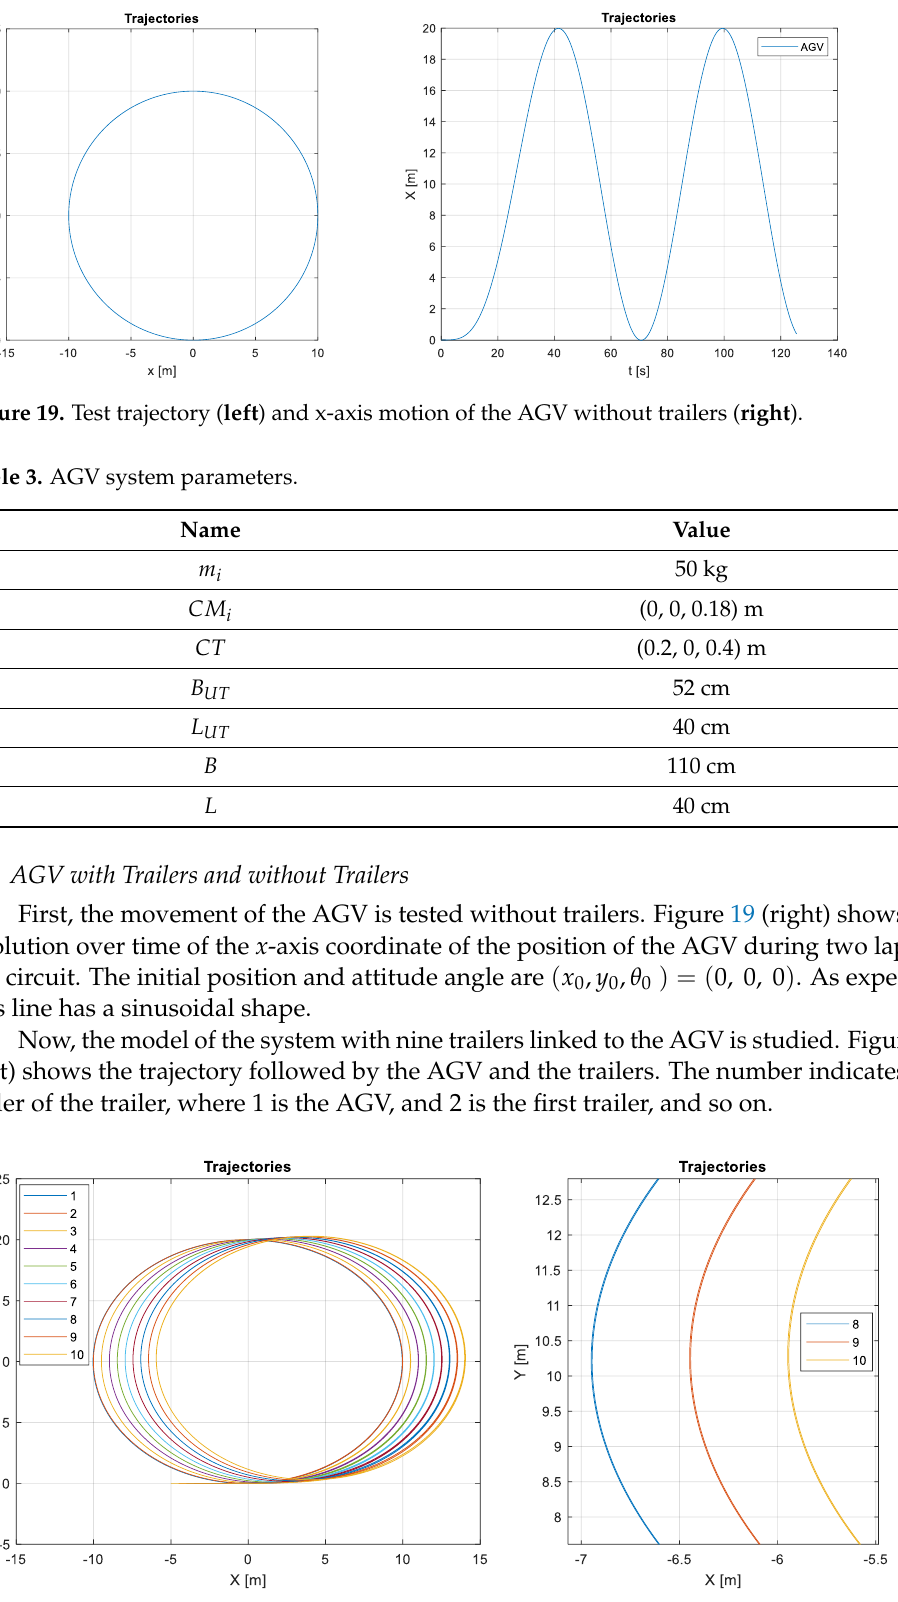
Figure 20. Trajectory followed by the AGV and the trailers ( left ) and a zoomed-in version of the three last trailers ( right